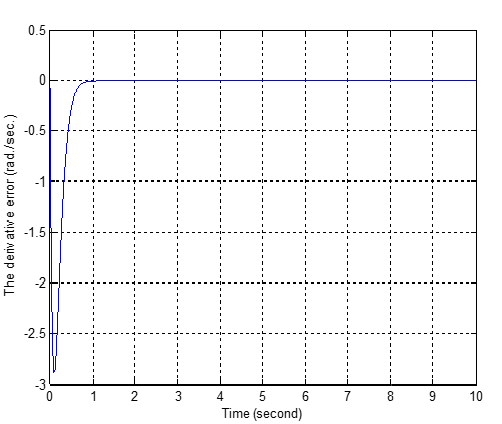
Fig. 23. The error _ vs. time of the ISMC. ‘